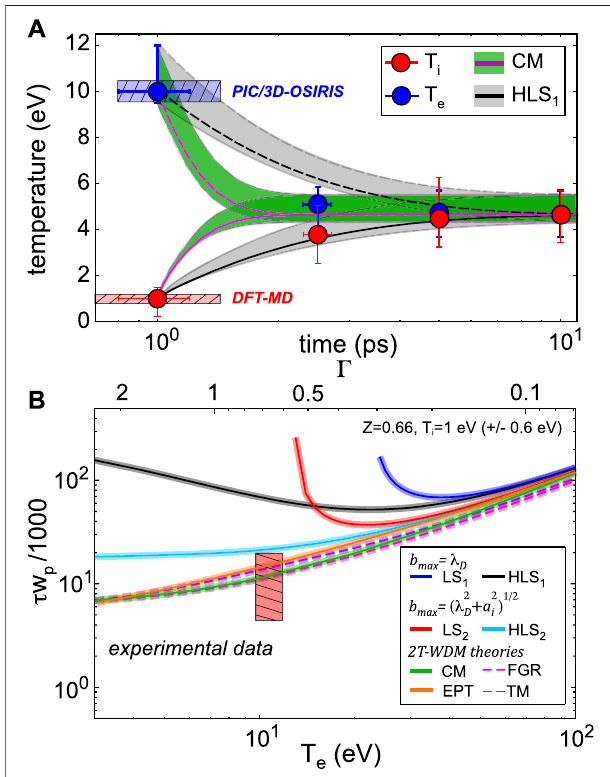
FIGURE 7 | (color online) (A) Temporal evolution of the electron temperatures (blue circles) and ion temperatures (red circles) as measured with XRTS. Predictions of the equilibration from various energy relaxation models. The curves are calculated from time t = 1 ps using n e = 3 × 10 22 cm − 3 , T e = 10 eV, T i = 1 eV, and Z = 0.66 as parameter inputs. Line thickness indicates uncertainty in T i . (B) Experimentally determined relaxation time τ / 1,000, in units of the inverse electron-plasma frequency plotted together with eight energy relaxation theories from the warm dense state to the classical conditions. Four classical and quasi-classical theories: Landau-Spitzer (LS) relaxation using different Coulomb logarithms Λ LS = ln ( b max / b min ), hyperbolic Landau-Spitzer (HLS), Λ HLS (cid:2) 1 2 ln ( 1 + ( b 2 max / b 2 min )) where b min (cid:2) ( λ 2 + ρ 2 ⊥ ) 1/2 for all cases. Four 2T-WDM theories: coupled mode (CM) [15], Fermi golden rule (FGR) [28], T-matrix (TM) [14], and effective potential theory (EPT)